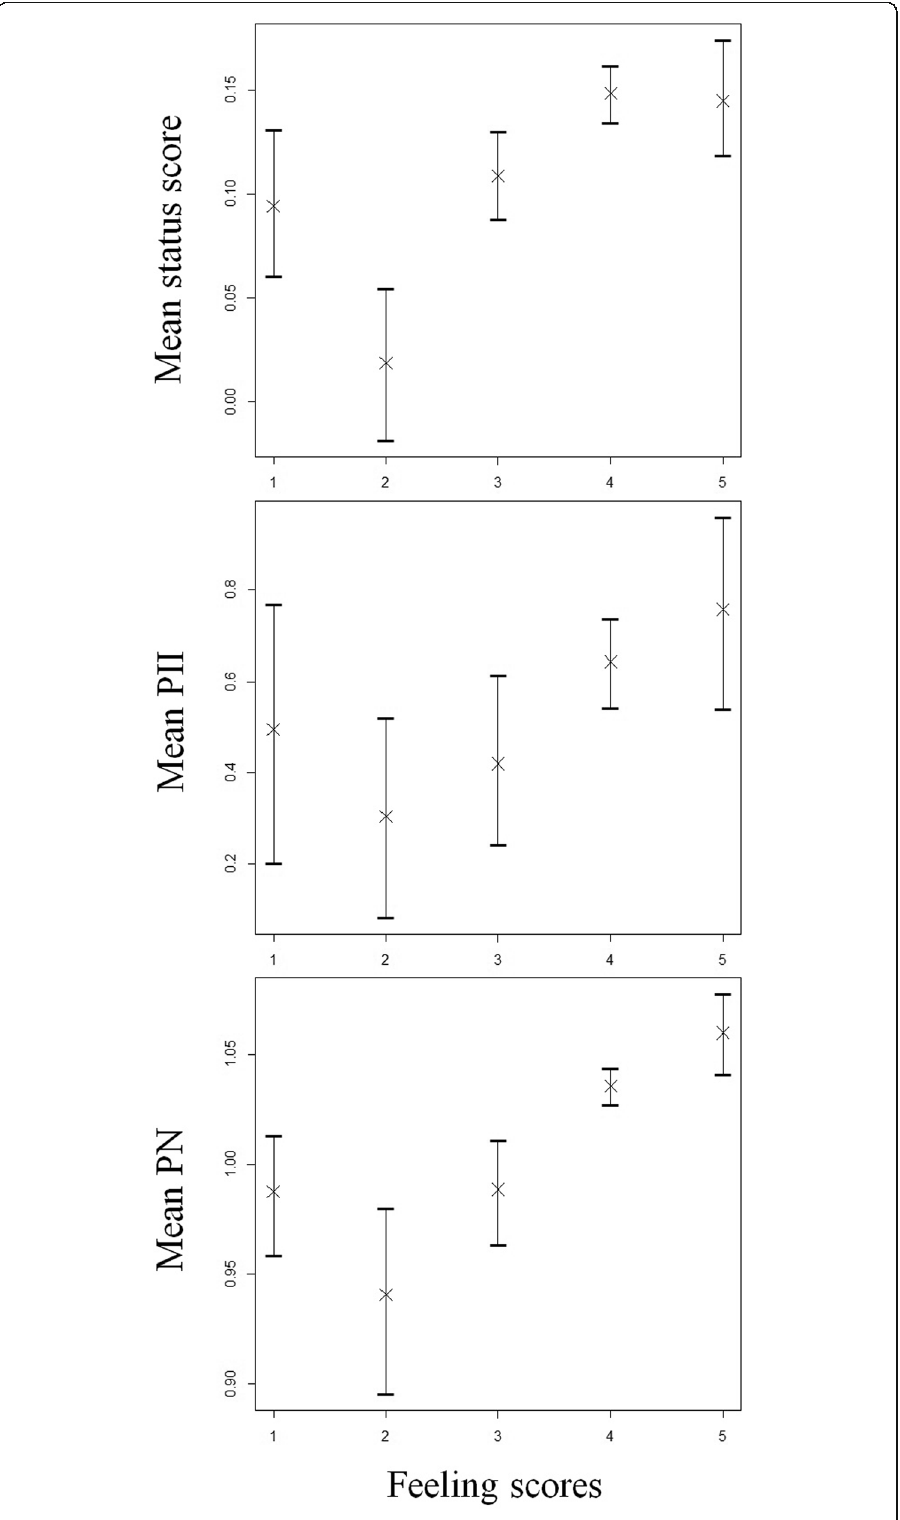
Fig. 9 Mean status score (top), mean PII centrality (middle) and mean PN centrality (bottom) plotted against the feeling score of individual students after pooling all results together from our analysis on the Hungarian high school dataset (crosses and bars are means and the 95% confidence intervals